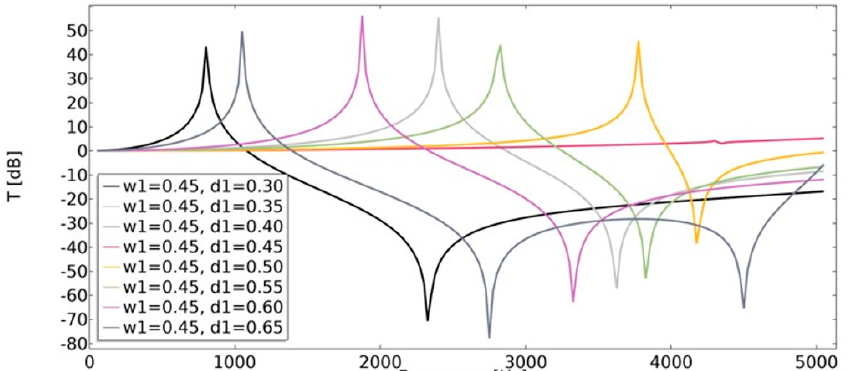
Figure 24. The influence of geometric features on the value of transmissibility in vertical direction for w 1 = 0.35.